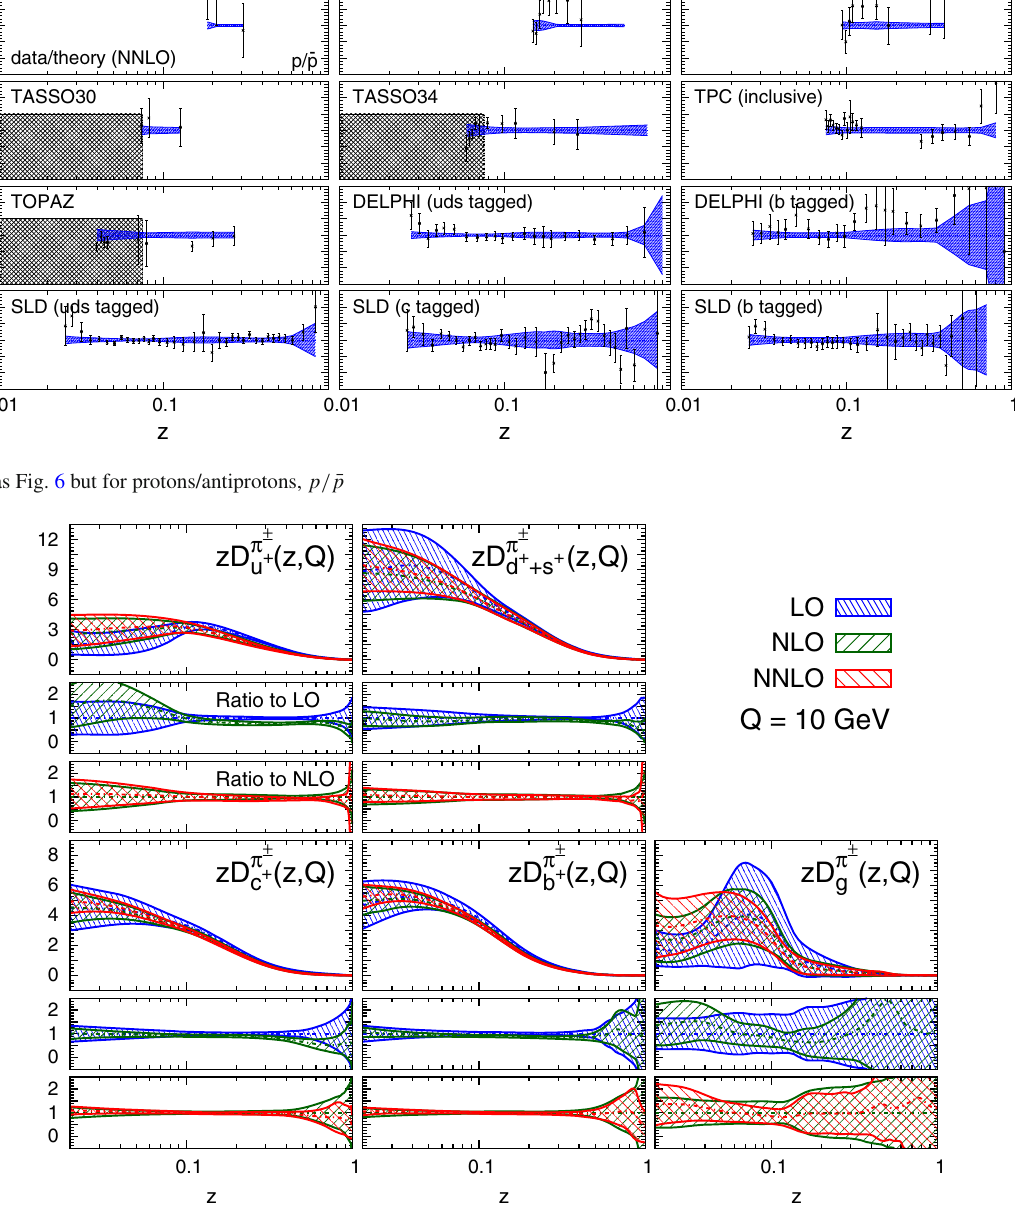
Fig. 9 Comparison among the LO, NLO, and NNLO NNFF1.0 charged pion FFs, together with their one- σ uncertainties, in the parametrisation basis of Eq. (4.1) at Q = 10 GeV. The corresponding NLO/LO and NNLO/NLO ratios are displayed in the two insets below each